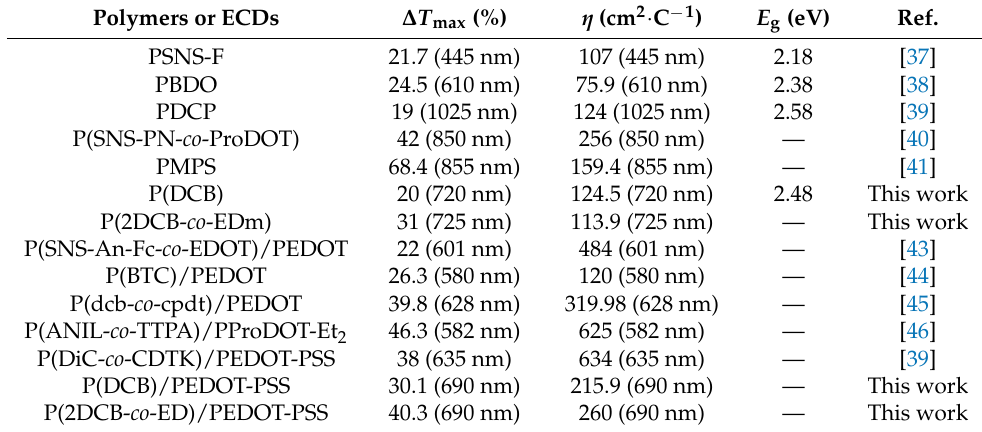
Table 4. Transmittance changes and coloration efficiencies of polymers (or